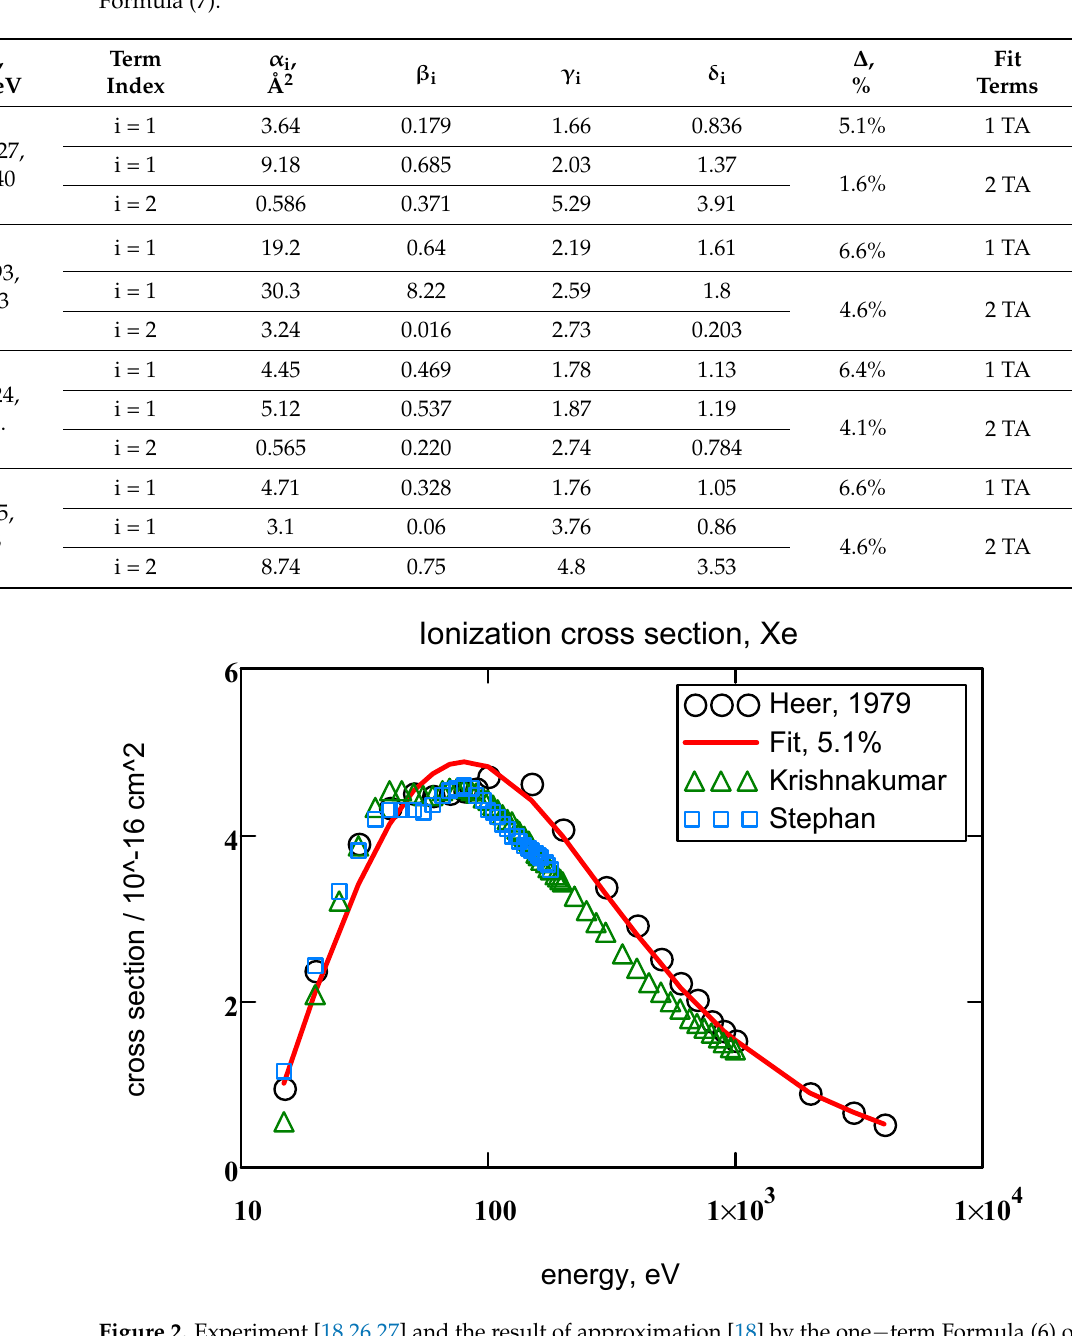
Figure 2. Experiment [18,26,27] and the result of approximation [18] by the one − term Formula (6) of the ionization cross section of xenon atoms with a mean square relative error of 5.1%.